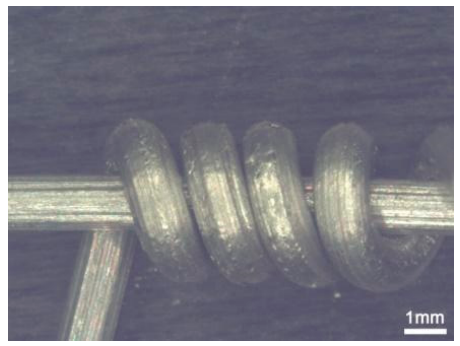
Figure 8. 0.75 wt.% MoB 2 .